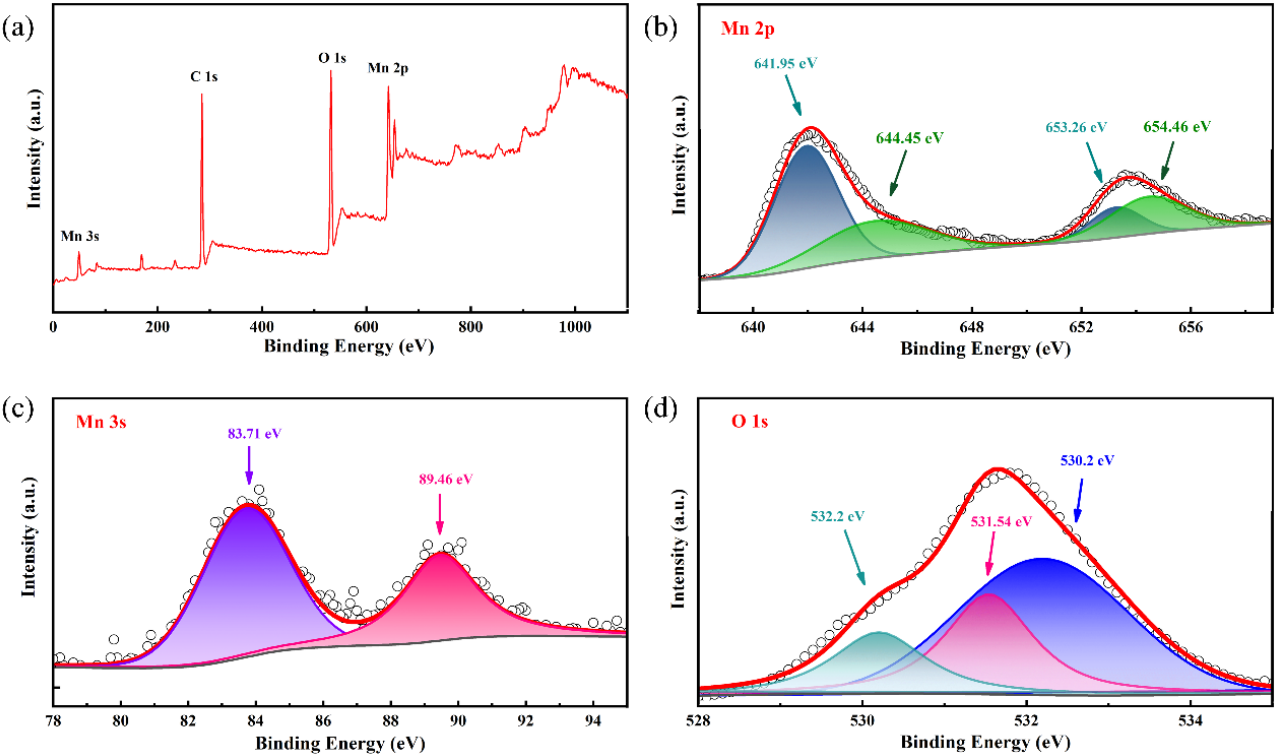
Figure 3. ( a ) The XPS spectra, ( b ) Mn 2p, ( c ) Mn 2s and ( d ) O 1s core-level XPS spectra of as-prepared Mn(OH) 2 nanowire